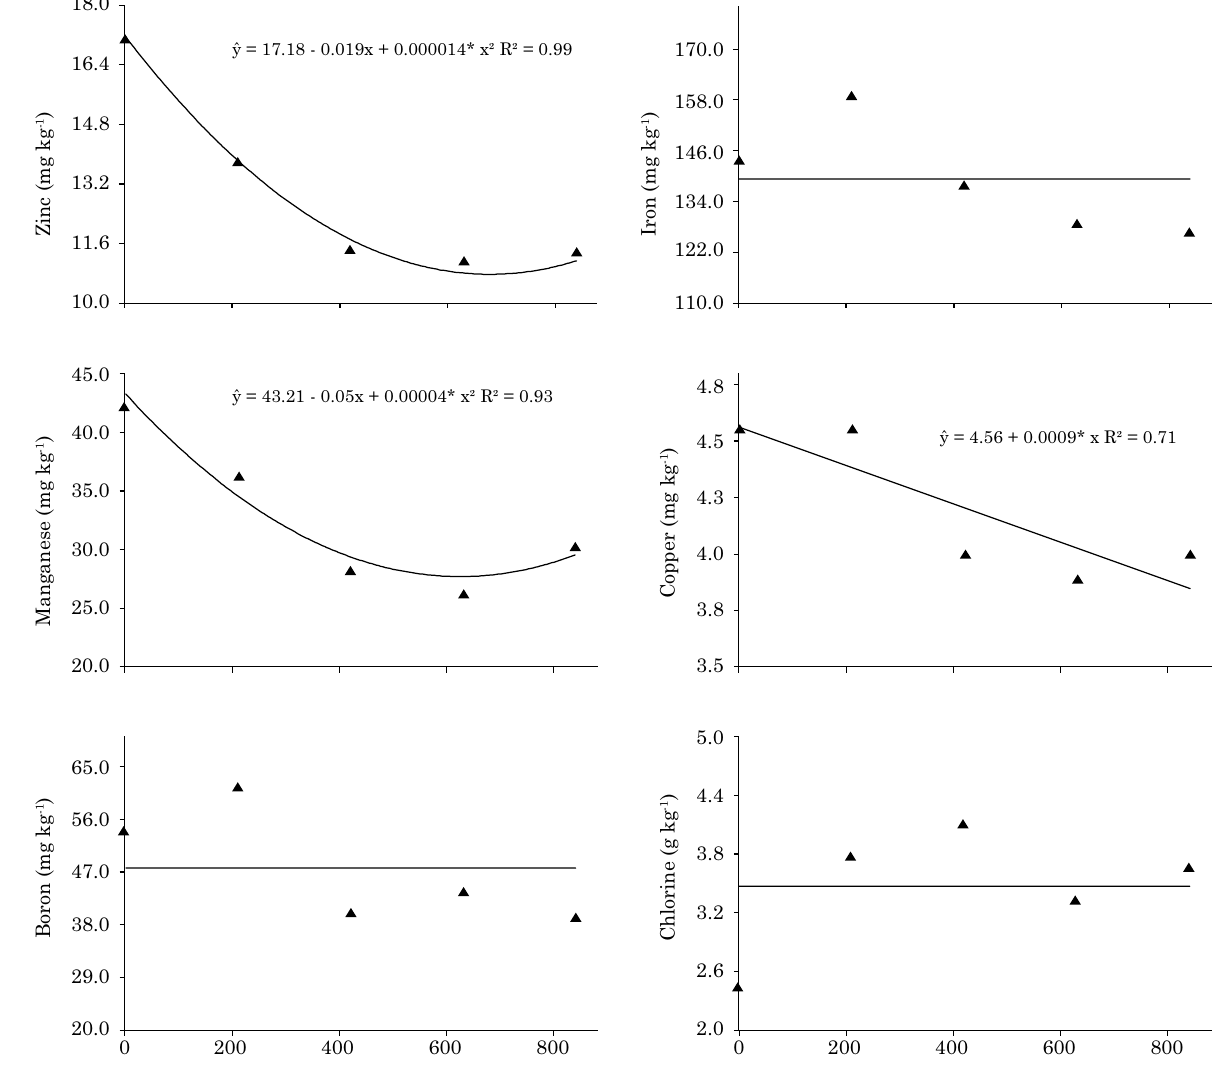
Figure 4. Variation in mineral nutrients contents of macaw plants grown in the field for two years, in response to five side-dressed N and K rates. For B and Fe, effect of rate was not significant by the t test, at 5 %; for Cu, Mn, Mo and Cl, ** and * indicate significance of the regression coefficient at 1 and 5 % by the t test,